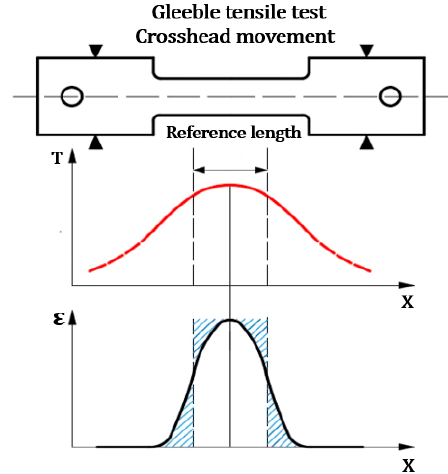
Figure 1. Temperature distribution with Gleeble